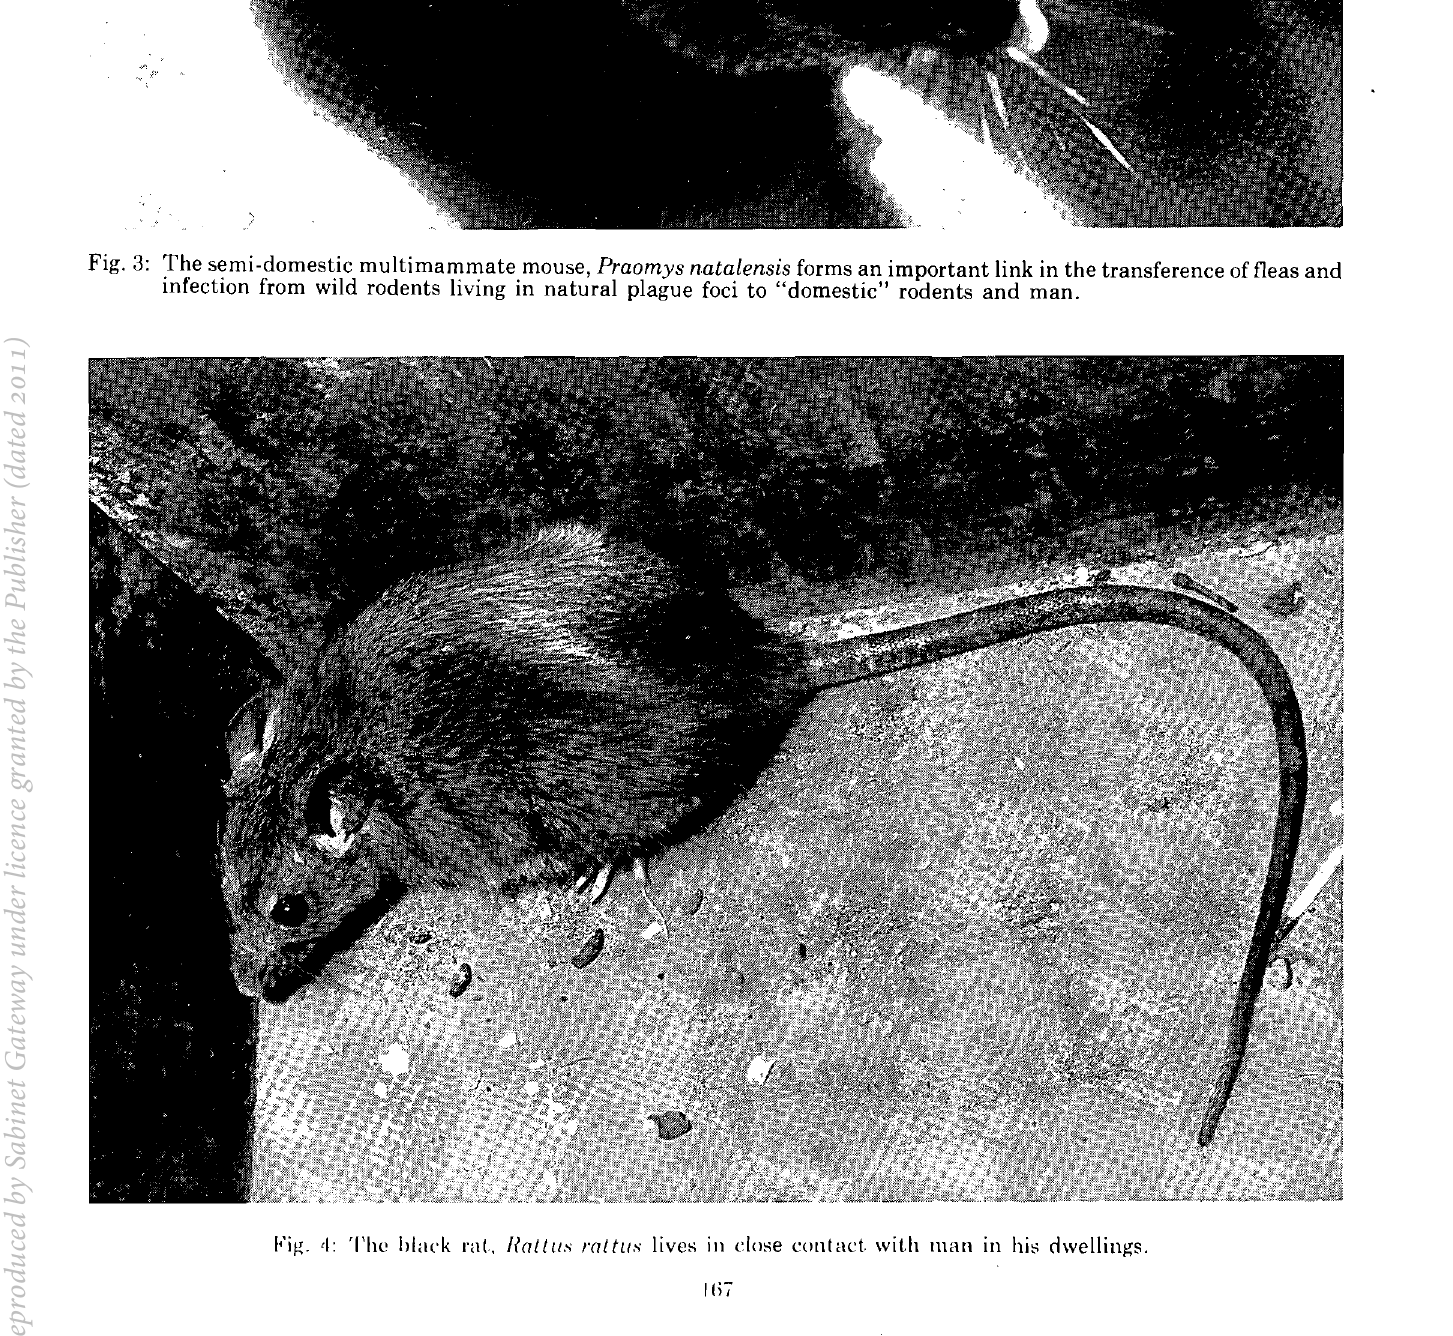
I<'ig. ,I: The black rae. Hnl/lis mltlls lives ill dose contact. with man 1Il hi~ rlwellings.